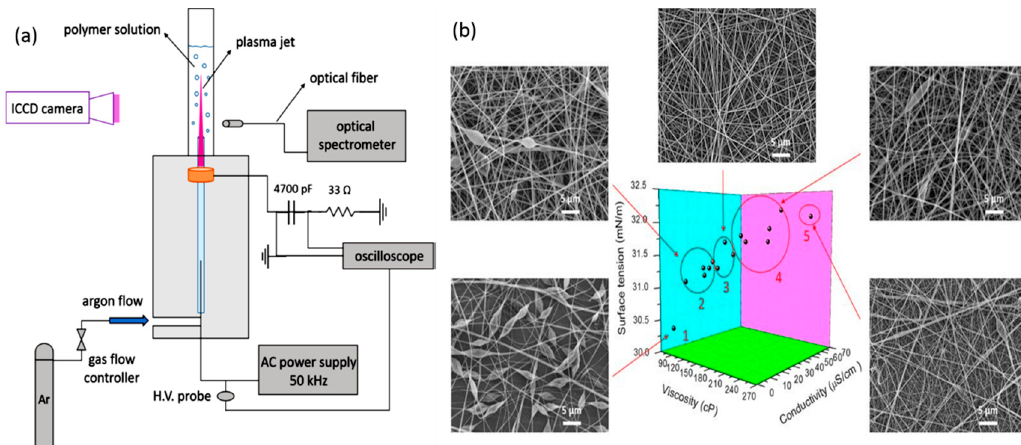
Figure 20. ( a ) Schematic representation of the atmospheric pressure argon plasma jet directly submerged into the liquid phase for PEPT used by Rezaei et al. [345,346], ( b ) 3D image of the physical properties and SEM images of PLA nanofibers produced from plasma-treated solutions. Reprinted from [345].